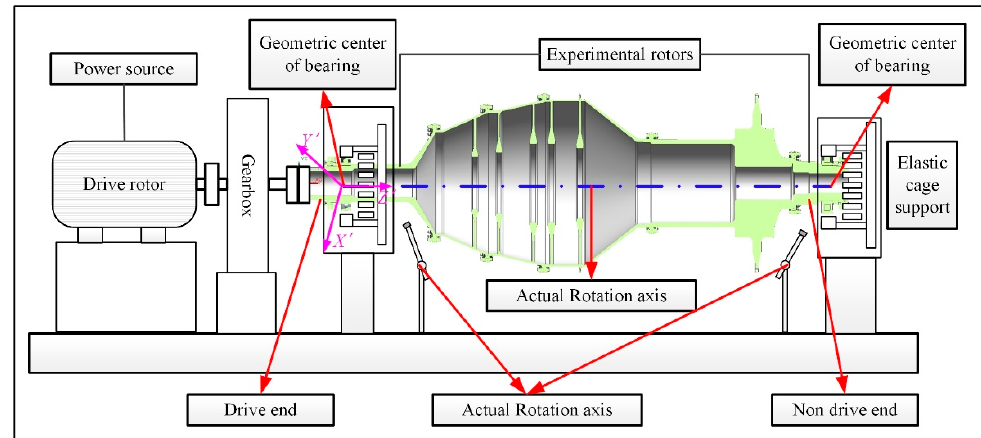
Figure 7. Rotary parts vibration test device.